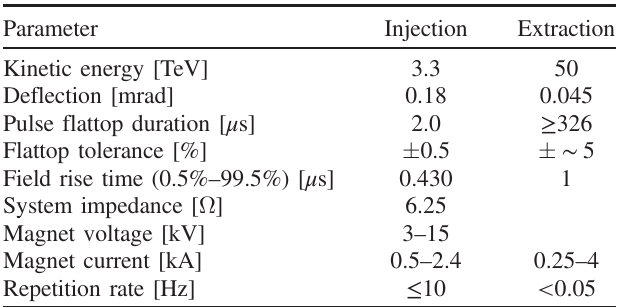
TABLE I. Injection and extraction kicker requirements for the FCC [6 –